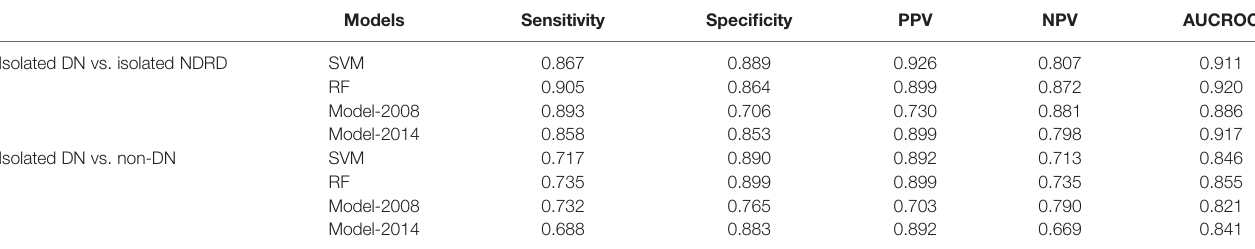
TABLE 3 | Performance for SVM and other models in external validation.